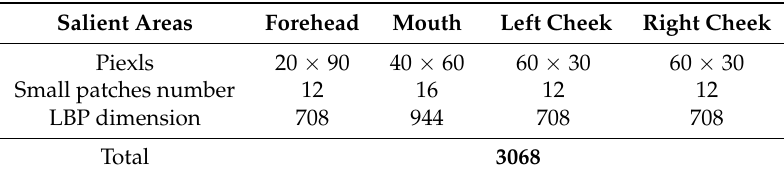
Figure 5. Small patches of salient areas. ( a ) Mouth areas, anger, fear, happy; ( b ) Forehead areas, anger, fear; ( c ) Cheek areas, left cheek fear, right cheek fear, left cheek anger, left cheek happy, right cheek happy. Table 1. Patches numbers and LBP dimensions of salient